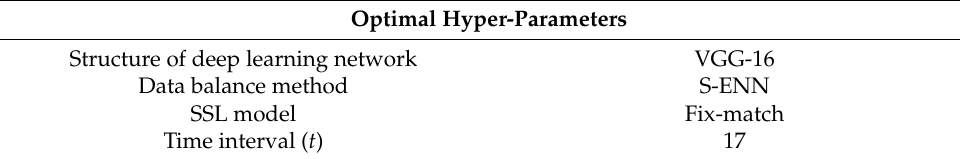
Table 7. Optimal hyper-parameters selected in the